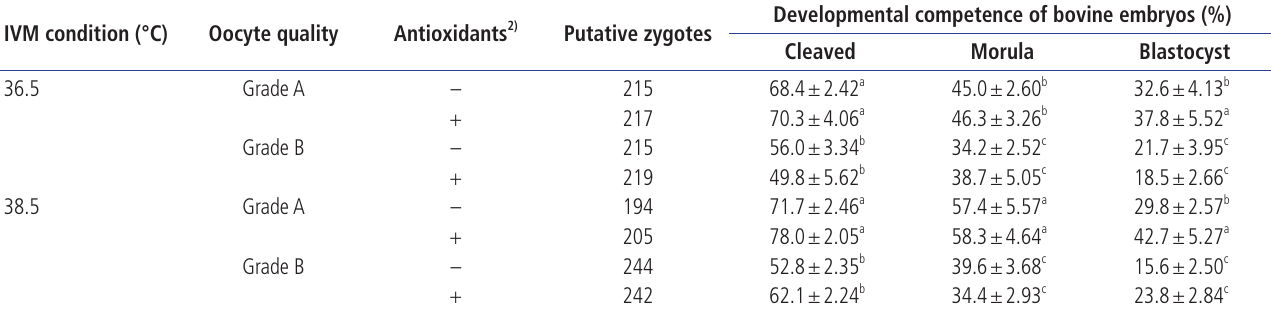
Table 3. Effect of incubation temperatures during in vitro maturation and antioxidants in embryo culture media on developmental competence of embryos 1) IVM condition (°C) Oocyte quality